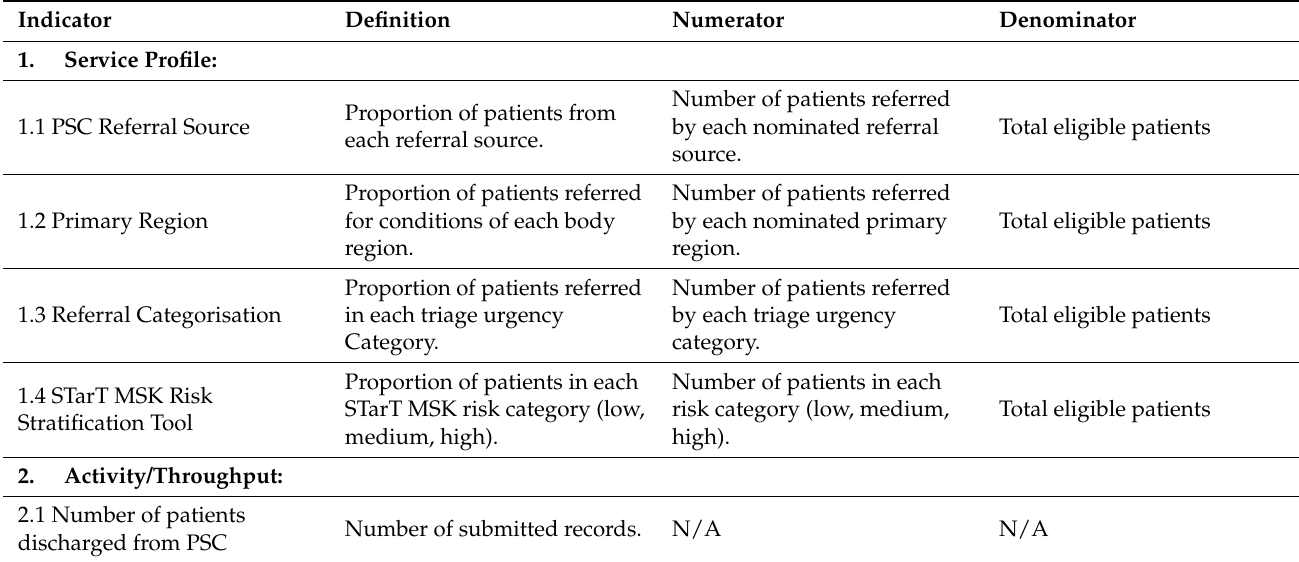
Table A2. Performance indicators against which the standardised dataset is